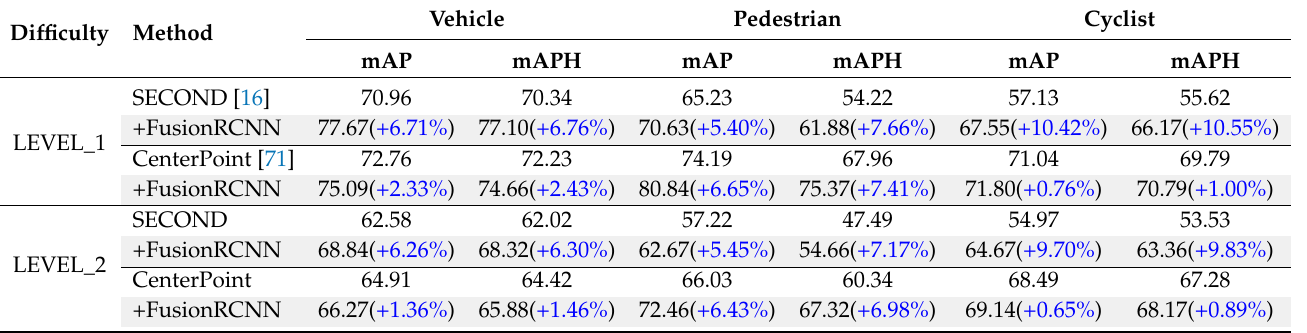
Table 2. Multi-class 3D detection results on Waymo validation set. Both SECOND and CenterPoint baselines are implemented in OpenPCDet. “+FusionRCNN” means that we add our FusionRCNN on the baseline detector. The performance improvements are painted in